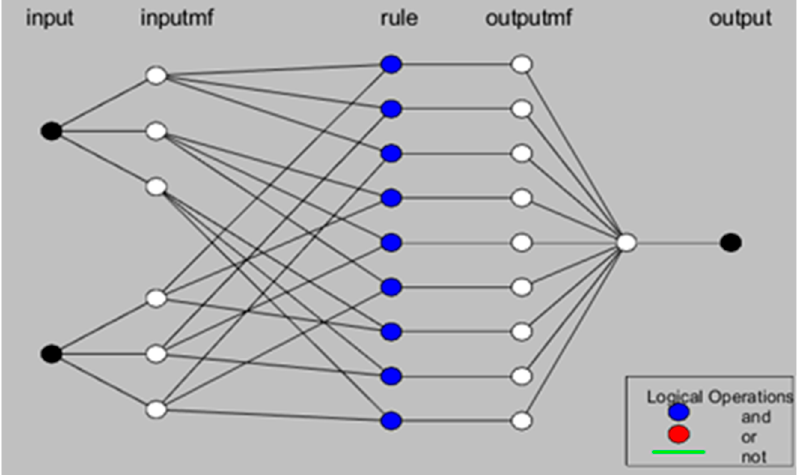
Figure 24. ANFIS structure developed by using grid partitioning.